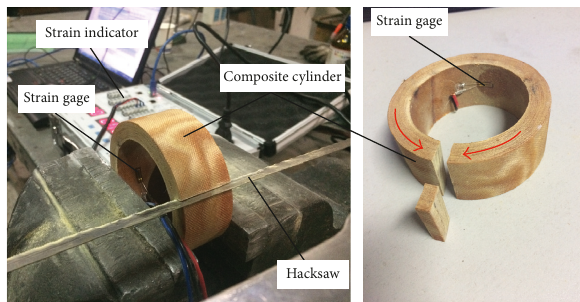
Figure 6: A slitting experiment for measuring residual stress.